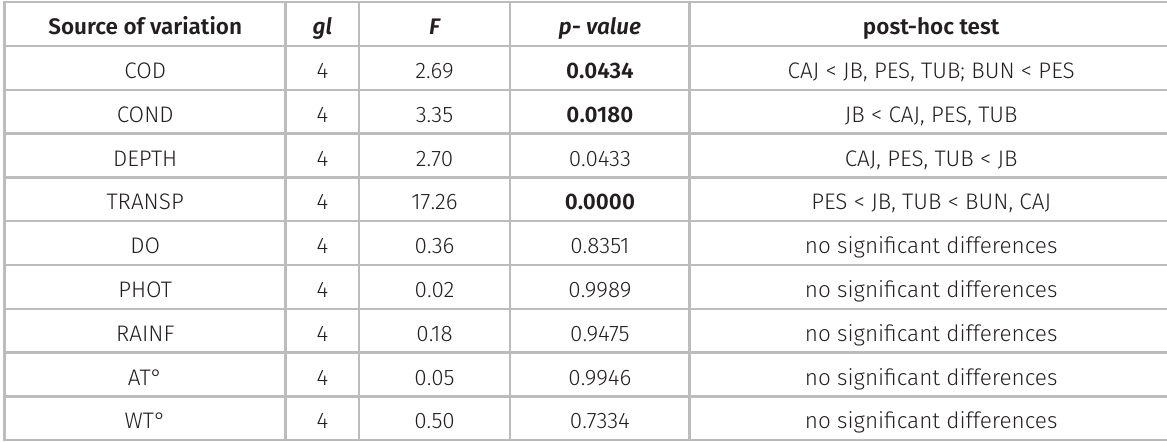
Table III. One-way ANOVA test on the physicochemical, hydrological and environmental variables recorded at the sampling sites. In bold type, the significant p values (p ≤ 0.05) and the corresponding post-hoc